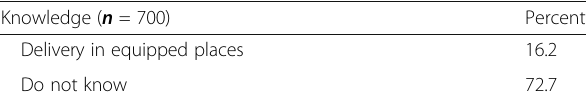
Table 2 Knowledge of reproductive-age women in Alexandria about TTV and MNT, 2018